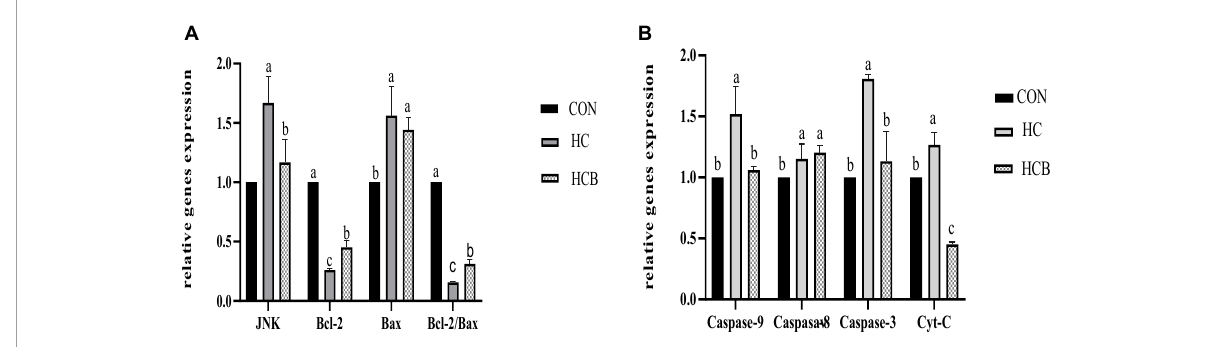
FIGURE2 Effects of high-concentrate diets and vitamin B1 supplement treatments on the apoptosis-related genes expression of rumen epithelium. (A) Effects of high-concentrate diets and vitamin B1 supplement on the relative expression of JNK, Bcl-2, and Bax. (B) Effects of high-concentrate diets and vitamin B1 supplements on the relative expression of Caspase-9, Caspase-8, Caspase-3, and Cyt-C. CON, control treatment; HC, high-concentrate diet treatment; HCB, high-concentrate diet supplemented with vitamin B1 treatment. a,b,c means within different letters the gene expression differed significantly ( P < 0 . 05).